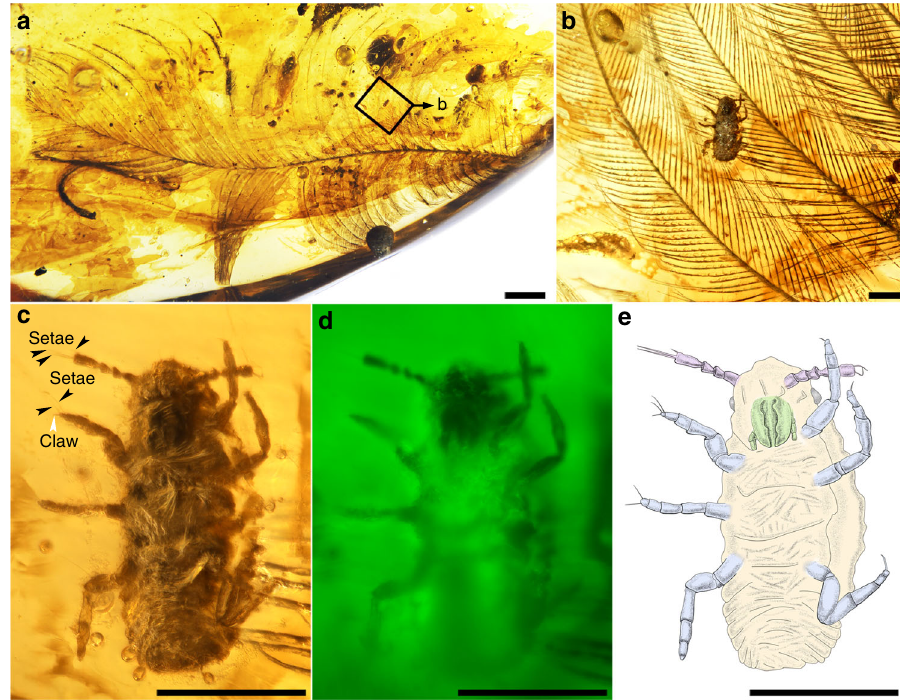
Fig. 3 AMBER No. 02 with the paratype of Mesophthirus engeli Gao, Shih, Rasnitsyn & Ren, gen. et sp. nov. from the mid-Cretaceous of Myanmar. a Photo of the whole feather and the location of the insect. b Enlargement of the insect crawling on the feather. c Paratype of M. engeli sp. nov., CNU-MA2016010. d CNU-MA2016010 under green epi fl uorescence. e Line drawing of c . Scale bars, 1 mm ( a ), 0.1 mm ( b – e ).